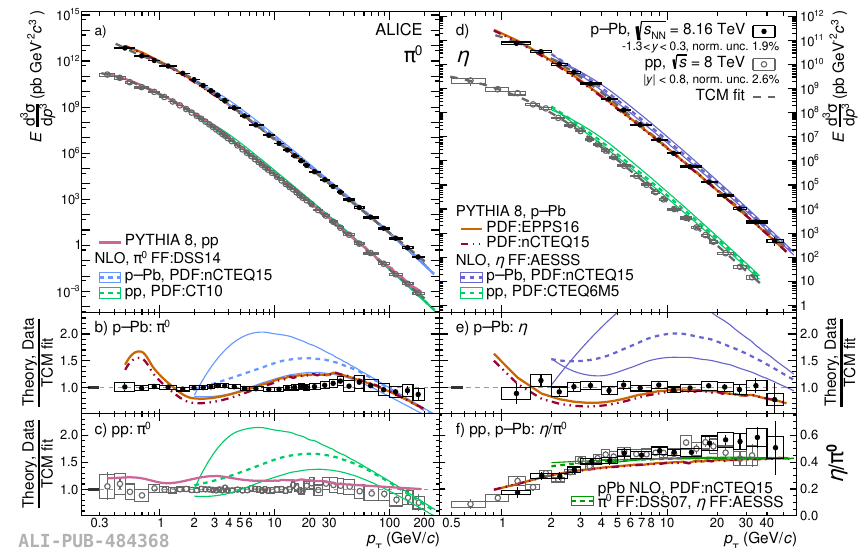
Figure 1: π 0 (a) and η (d) meson differential invariant cross section for pp at (cid:112) (cid:112) = 8.16 TeV together with PYTHIA 8 and NLO s = 8 TeV and for p–Pb at s NN calculations. (b), (c) and (e) show ratios of the data and theory calculations to the two component model (TCM) parametrizations [ 6 ] and (f) shows the η/π 0 ratio for both pp and p–Pb collisions together with theory calculations. Figure from [ 7 ]